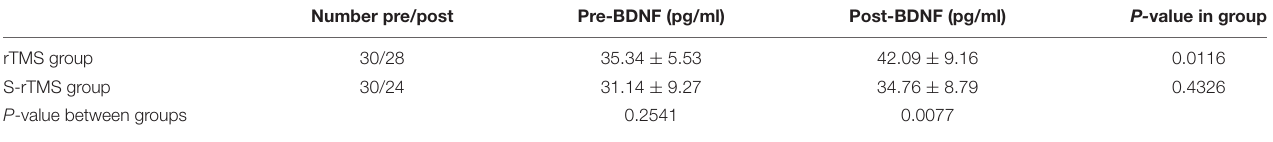
TABLE 3 | Comparison statistical scores of serum BDNF levels before and after treatment in the two